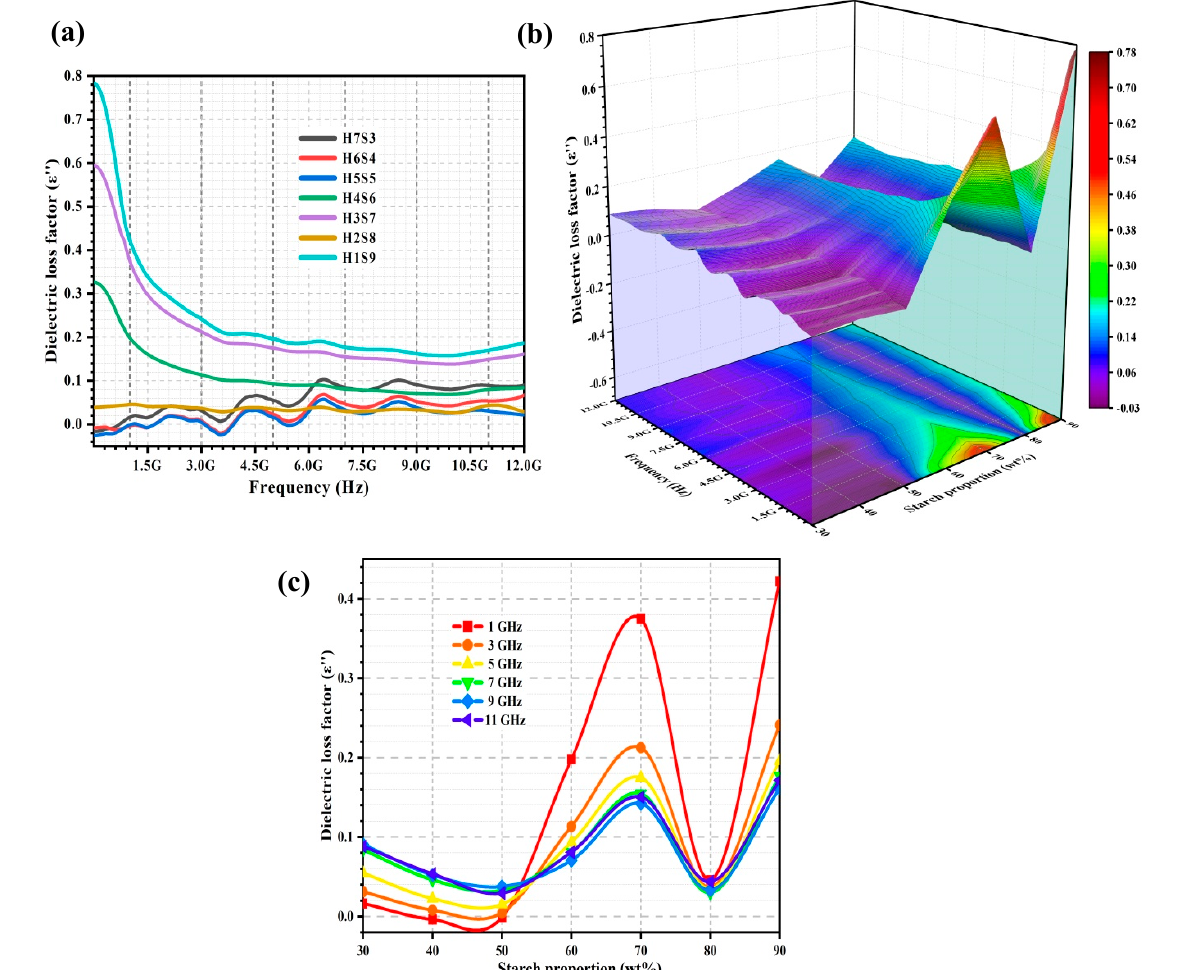
Figure 4. ε″ ( a ) of the porous nHA/S composites; 3D representation of ε″ of the porous nHA/S Figure 4. ε (cid:48)(cid:48) ( a ) of the porous nHA/S composites; 3D representation of ε (cid:48)(cid:48) of the porous nHA/S composites ( b ); ε″ curves of the porous nHA/S composites at various frequencies ( c ). composites ( b ); ε (cid:48)(cid:48) curves of the porous nHA/S composites at various frequencies ( c In the porous nHA/S composite with high starch proportion (60–90 wt%), the ε″